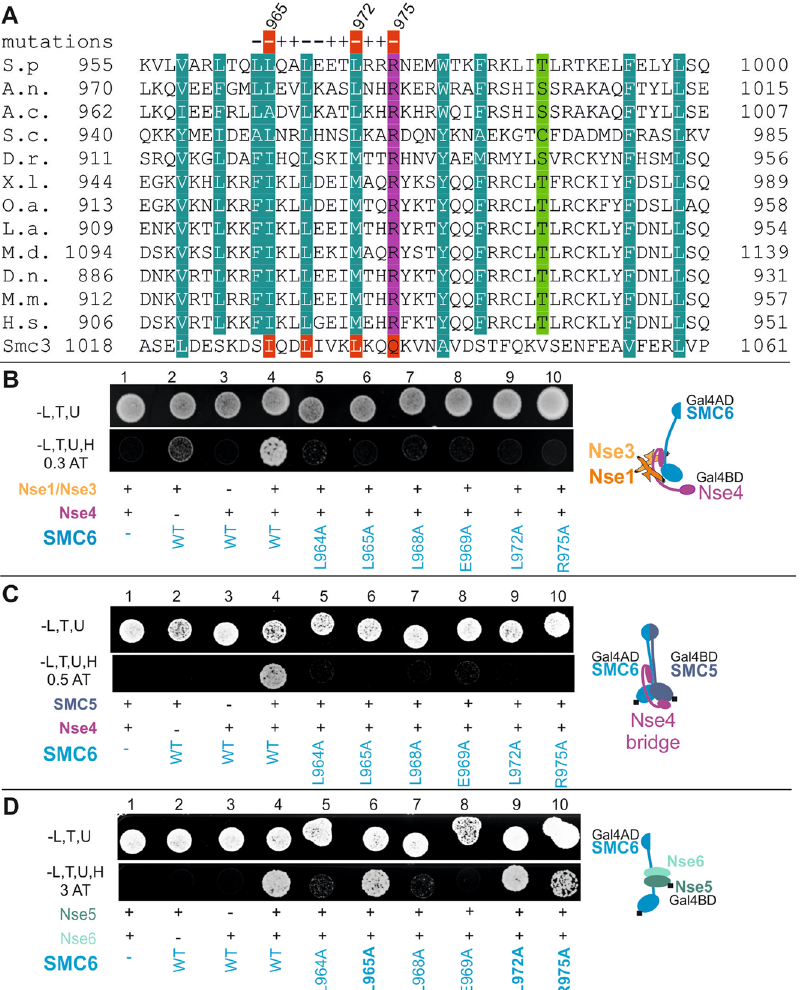
Figure 1. Nse4 binds neck region of the SMC6 protein. ( A ) Alignment of the C-terminal SMC6 neck region. The SMC6 orthologs are from Schizosaccharomyces pombe ( S.p .), Aspergillus nidulans ( A.n .), Aspergillus clavatus ( A.c .), S. cerevisiae ( S.c .), Danio rerio ( D.r .), Xenopus laevis ( X.l .), Ornithorhynchus anatinus ( O.a .), Loxodonta africana ( L.a .), Monodelphis domestica ( M.d .), Dasypus novemcinctus ( D.n .), Mus musculus ( M.m .), Homo sapiens ( H.s .). The SMC3 sequence from S. cerevisiae represents SMC binding mode present in the SMC3-Scc1 crystal structure (PDB: 4UX3). “ + ”, mutation not affecting SMC6 interactions; “ − ”, mutation disrupting all SMC6 complexes; red minus, mutation specifically disrupting the Nse4-SMC6 interaction; the red-highlighted SMC3 amino acids correspond to the Scc1-contacting residues. Amino acid shading represents following conserved amino acids: dark green , hydrophobic and aromatic; light green , polar; pink , basic; blue , acidic. Multi- component yeast two-hybrid systems ( B–D ) were employed to determine SMC6 region and residues binding to Nse4. Impact of mutations on the stability of the following SMC6 complexes was tested: SMC6-Nse4-Nse3-Nse1 ( B ), SMC6-Nse4-SMC5 ( C ) and SMC6-Nse5-Nse6 ( D ). Schematic representation of the complexes is at the right side of each panel. ( B ) The full-length hybrid SMC6 and Nse4 constructs were co-transformed together with p416ADH1-Nse1 + Nse3 plasmid into S. cerevisiae PJ69 cells. Formation and stability of the SMC6-Nse4- Nse3-Nse1 complex was scored by growth of yeast PJ69 transformants on plates without leucine, tryptophan, uracil and histidine, containing 0.3 mM 3-Amino-1,2,4-triazole (-L,T,U,H, 0.3AT panel). The L964A, L965A, L968A, E969A, L972A and R975A mutations reduce stability of the SMC6 complexes. ( C ) Similarly, the SMC6 and SMC5 were co-transformed together with p416ADH1-Nse4 construct and stability of the SMC5-Nse4- SMC6 complex was scored on plates containing 0.5 mM 3-Amino-1,2,4-triazole (-L,T,U,H, 0.5AT panel). The L964A, L965A, L968A, E969A, L972A and R975A mutations reduce stability of the SMC6 complexes. ( D ) In the control experiment, the same mutations were tested in the SMC6-Nse5-Nse6 complex (constituted of the full- length Gal4AD-SMC6, Gal4BD-Nse5 and non-hybrid Nse6) on plates containing 3 mM 3-Amino-1,2,4-triazole (-L,T,U,H, 3AT panel). The L964A, L968A and E969A mutations affect all SMC6 complexes ( B–D ), while the L965A, L972A and R975A mutations reduce only stability of the SMC6-Nse4 complexes ( B , C ), suggesting that the highly conserved L965, L972 and L975 residues are specifically required for the SMC6 interaction with Nse4. Wild-type (WT) or mutant versions of SMC6 are labelled in blue; “ − ”, denotes empty vector control; “ + ”, indicated construct was co-transformed; the Gal4 domain positions are labelled with the black box. Growth of the transformants was verified on the control plates (-L,T,U). All mY2H tests were repeated at least 3